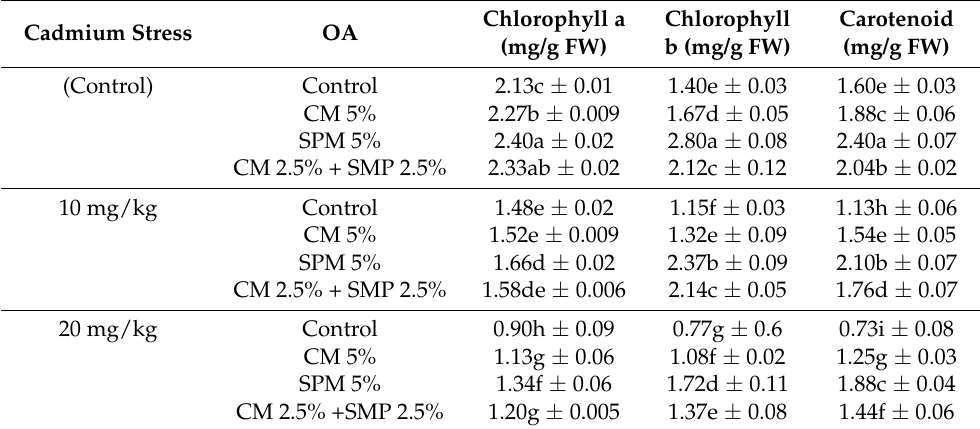
Table 1. Effect of different organic amendments on photosynthetic pigments of mash bean grown under different levels of Cd stress.